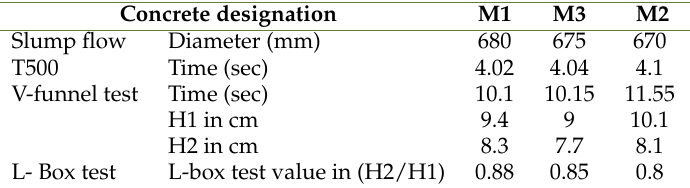
Table 2. Summary of test results on fresh SCC